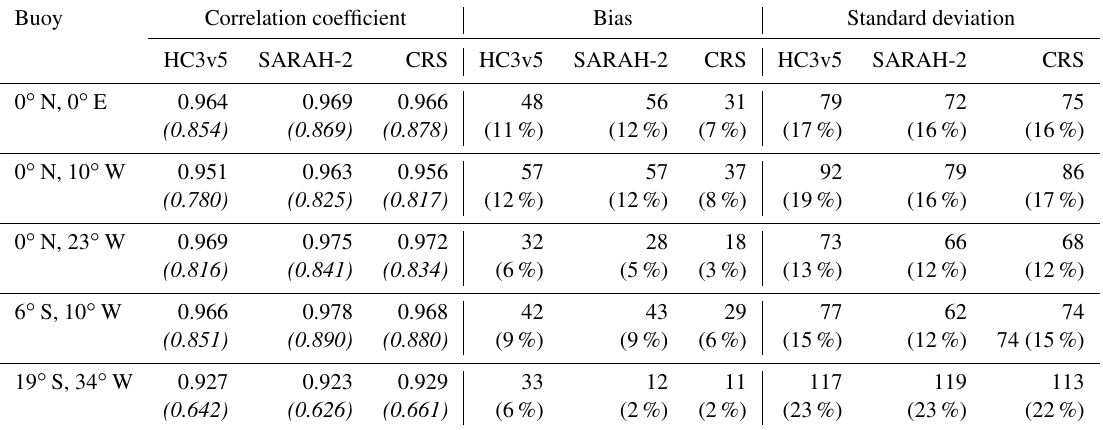
Table 3. Details for each PIRATA buoy and each satellite-derived data set: correlation coefficient between measurements and estimates from satellite-derived data sets for irradiance and clearness index (in italics), bias and standard deviation (Wm − 2 ) between measurements and estimates for irradiance with relative values (in brackets) for hourly means in the period 2012–2013. Buoy